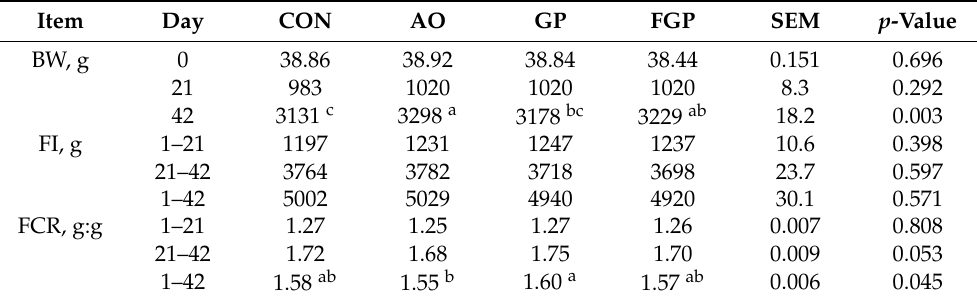
Table 3. Growth performance of broiler chickens fed diets containing raw grape pomace, fermented grape pomace, and synthetic antioxidants 1